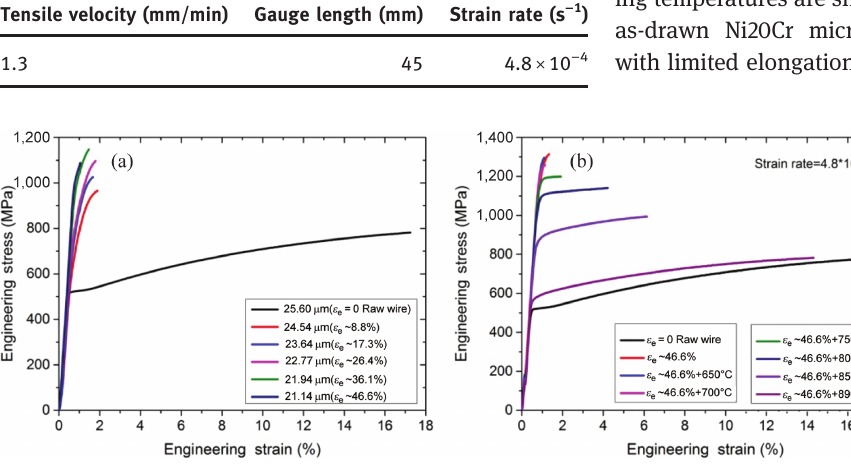
Table 2: Strain rate parameters of stress-strain tests.